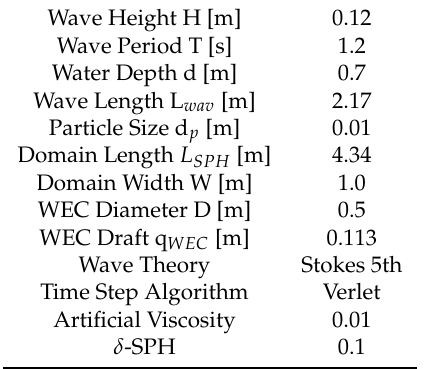
Figure 12. Numerical set-up for 3D modelling of a heaving cylindrical WEC in a two-way coupled model. Table 3. Simulation parameters for 3D modelling of a heaving cylindrical